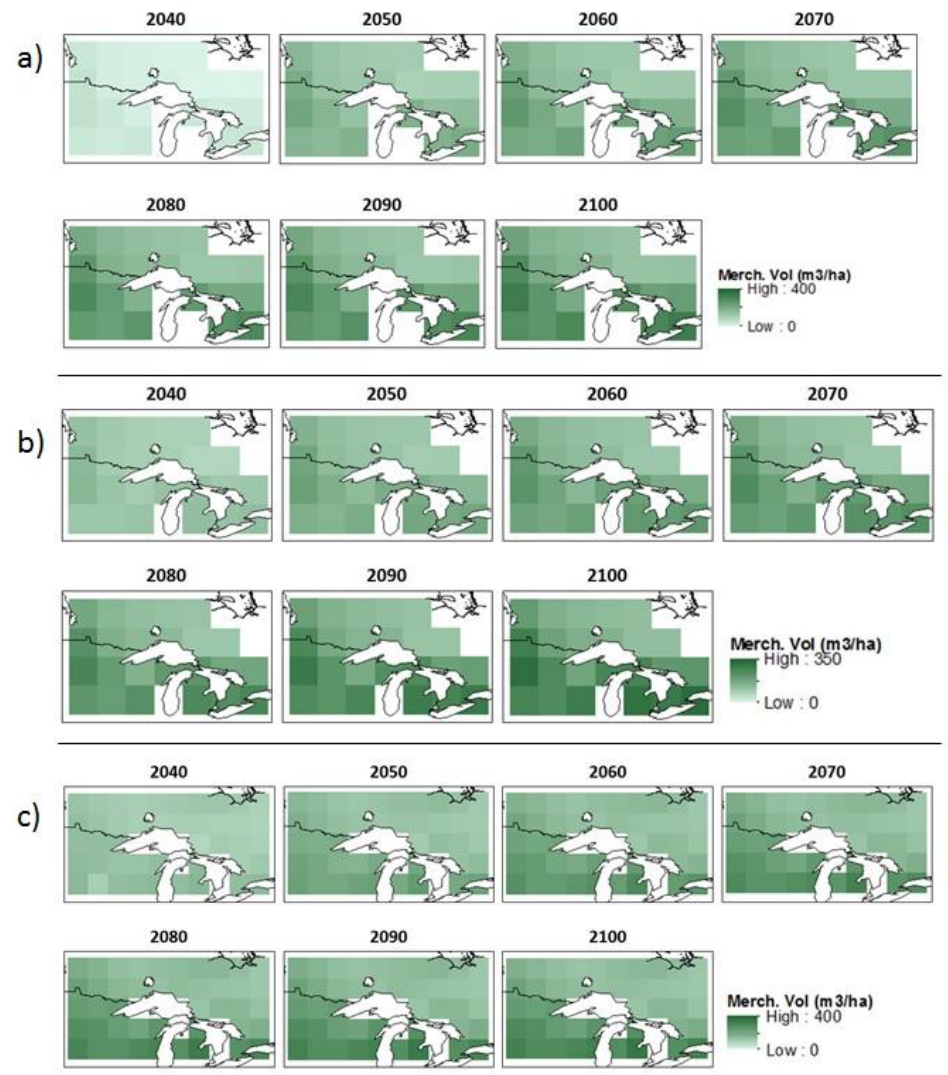
Figure 3. Spatial distribution of projections of annual Net Primary Production (NPP) over time as simulated by the Global Climate Models: ( a ) CanESM2; ( b ) MIROC; and ( c ) MPI.